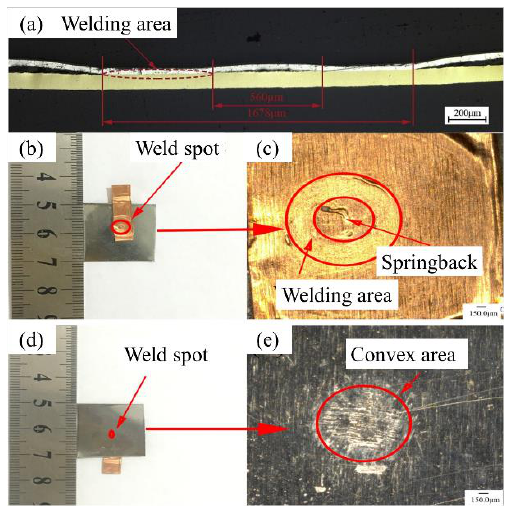
Figure 7. ( a ) Cross-section of weld interface at 1550 mJ energy (reprodueced from [27], with permission of Elsevier 2019); ( b – e ) Weld spot between molybdenum and copper (reproduced from [28], with permission of Elsevier 2019).